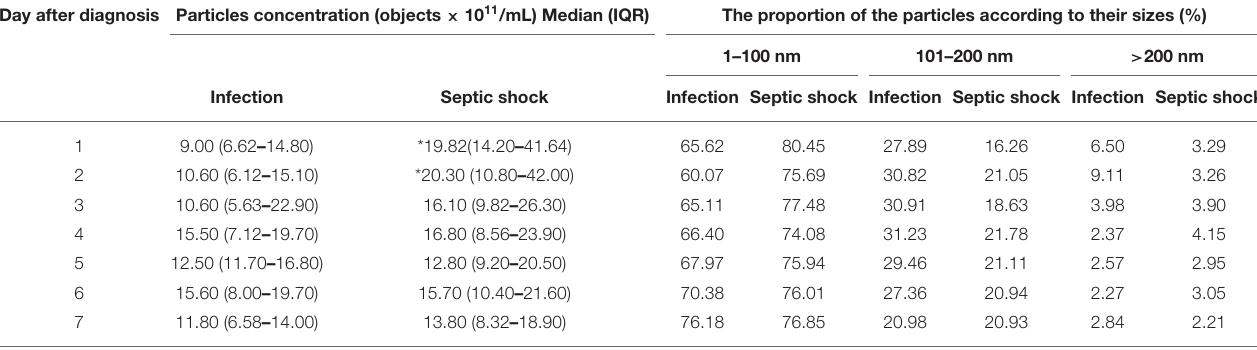
TABLE 2 | Concentrations and sizes of extracellular particles in PFP samples of patients with septic shock and infection † . Day after diagnosis Particles concentration (objects × 10 11 /mL) Median (IQR) The proportion of the particles according to their sizes (%) 1–100 nm 101–200 nm > 200